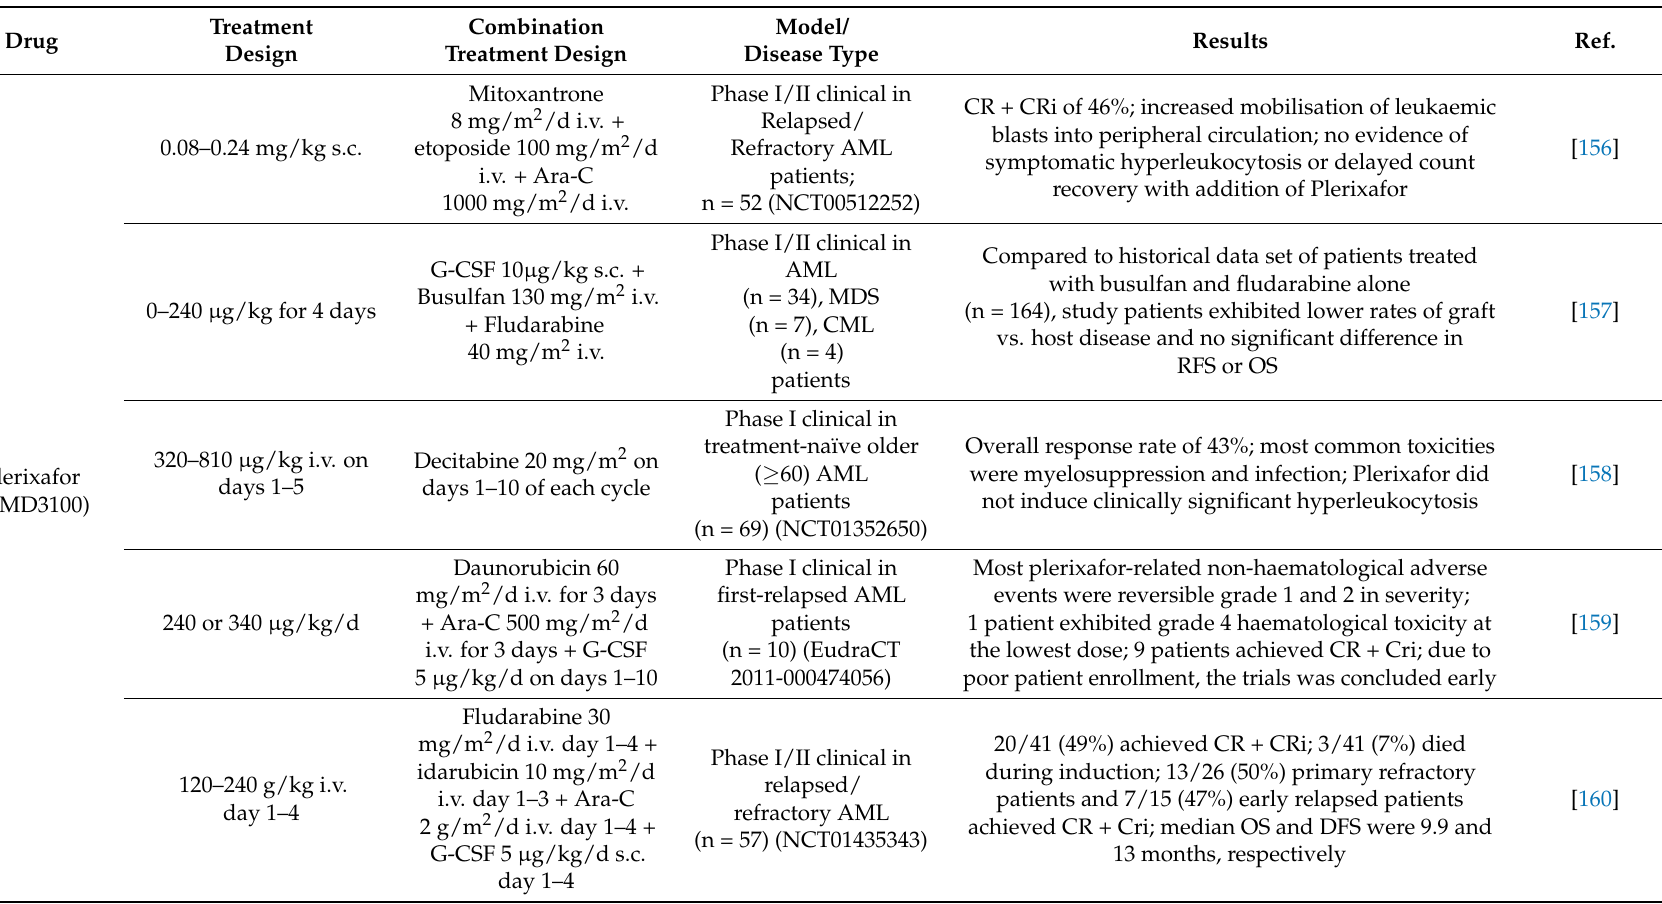
Table 2. Summary of strategies for targeting the bone marrow microenvironment as a treatment for AML that have been examined clinically in